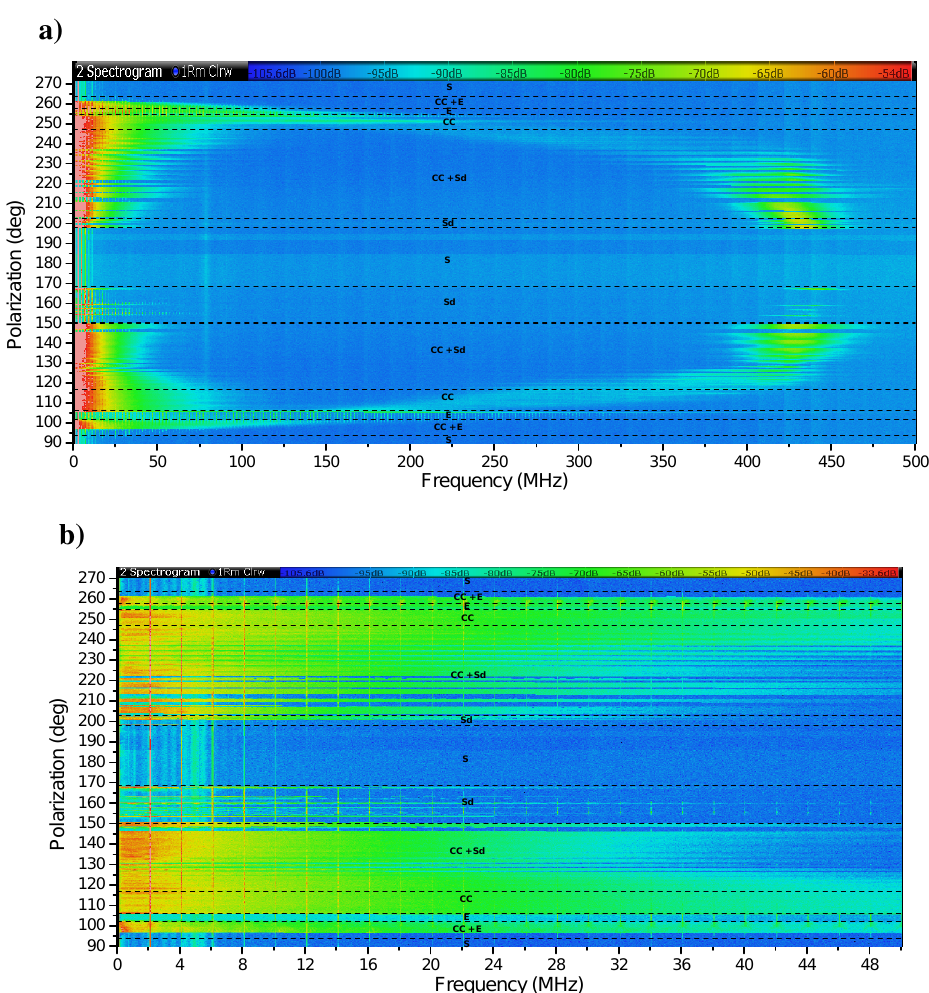
Figure 3. Spectrogram of the non-linear dynamics generated by the packaged QCL when varying the polarizer angle and, thus, the feedback ratio. This map was obtained when the packaged QCL was pumped far above threshold, with a sine excitation at 2 MHz and an amplitude of 500 mV peak-to-peak—( a ) For a frequency range up to 500 MHz and ( b ) for a frequency range up to 50 MHz. It is relevant to note that the configuration presented in the previous paragraph (a